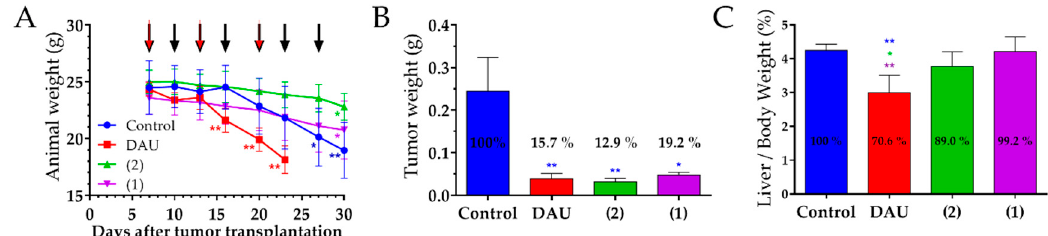
Figure 7. E ff ect of GnRH-III-Dau conjugates 1 and 2 (10 mg / kg Dau content, 7 treatments, black arrows) and free Dau (1 mg / kg, 3 treatments, red arrows) in orthotopic HT-29 human colon carcinoma bearing mice. ( A ) Animal body weight (grams, average ± SD). ( B ) Tumor weight (grams, average ± SEM) of mice from control, Dau, 1 and 2 groups after termination of experiment, 30 days after transplantation. ( C ) Liver weight / body weight ratio (percentage, average ± SD) of mice from control, Dau, 1 and 2 groups after termination of the experiment, 30 days after transplantation. Tumor and liver weight